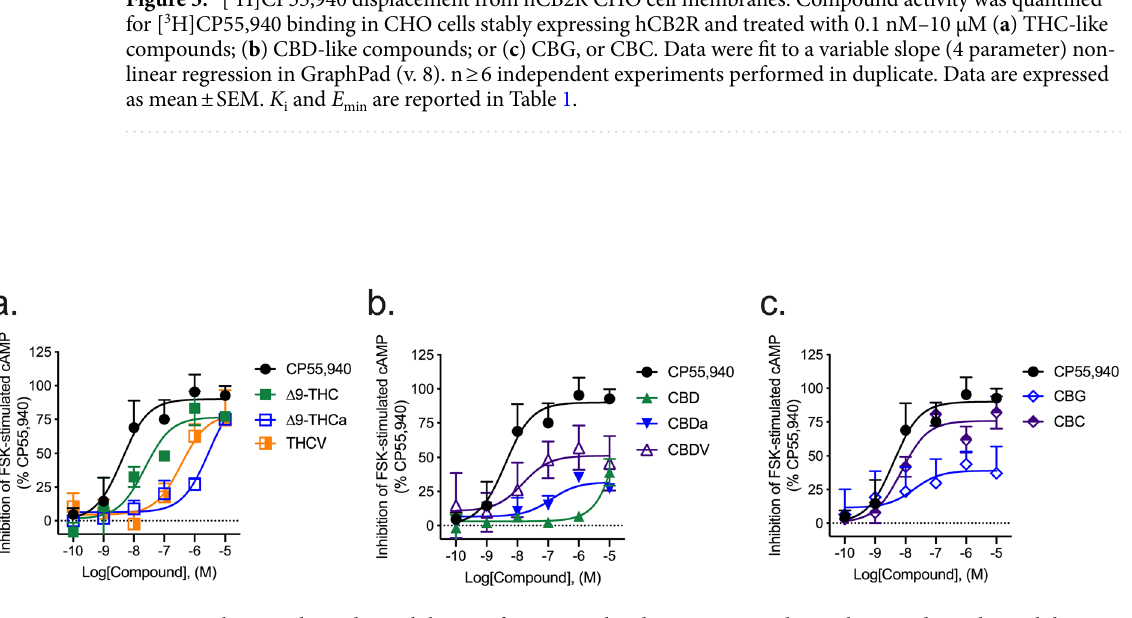
Figure 6. hCB2R-dependent inhibition of FSK-stimulated cAMP accumulation. hCB2R-dependent inhibition of FSK-stimulated cAMP accumulation was quantified in HitHunter CHO cells stably expressing hCB2R and treated with 0.1 nM–10 µM ( a ) THC-like compounds; ( b ) CBD-like compounds; or ( c ) CBG, or CBC for 90 min. Data were fit to a variable slope (4 parameter) non-linear regression in GraphPad (v. 8). n ≥ 6 independent experiments performed in triplicate. E Max refers to the top of the concentration–response curve. Data are expressed as mean ± SEM. EC 50 and E max are reported in Table